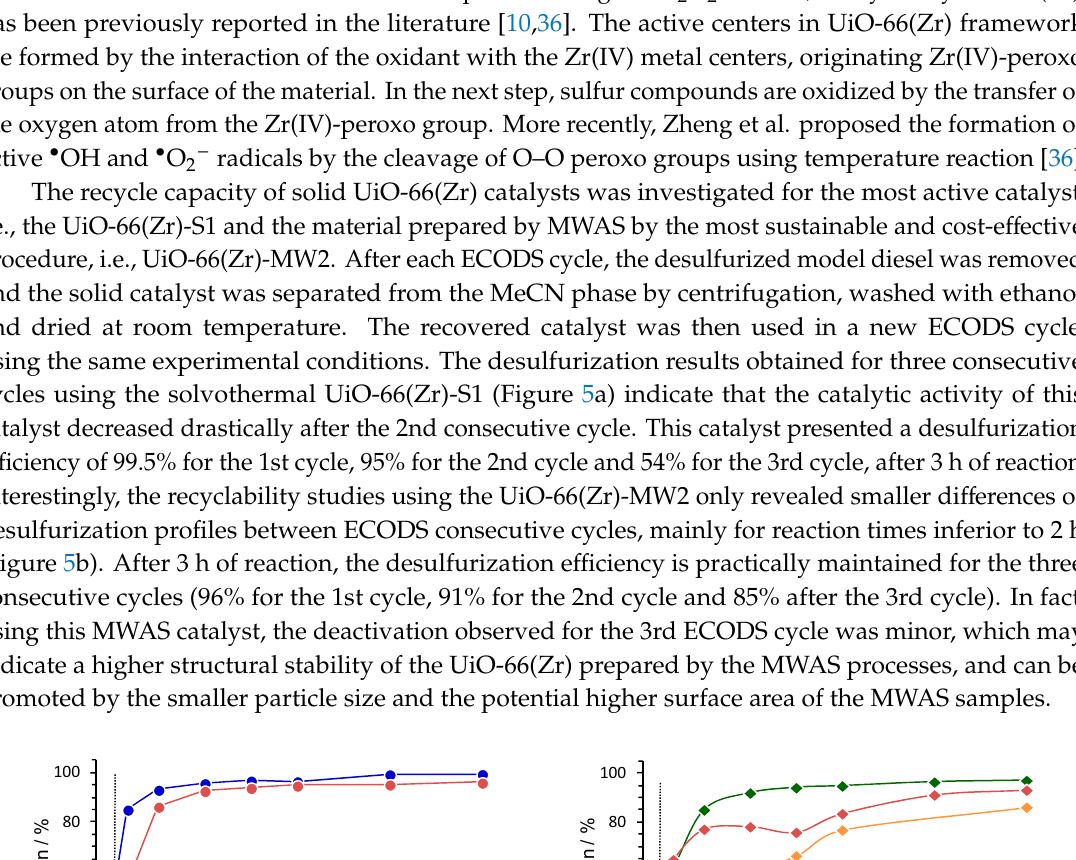
Figure 6. Desulfurization efficiency of UiO-66(Zr) catalysts used in different model diesel sulfur contents under similar experimental conditions (biphasic system model diesel/MeCN system, and H 2 O 2 as oxidant at 50–60 °C [9,37]. The catalytic desulfurization efficiency of the UiO-66(Zr) catalyst prepared in this work by the solvothermal procedure (UiO-66(Zr)-S1) and by the fast preparation procedure using MWAS (UiO- 66(Zr)-MW2) to treat the multicomponent model diesel with 1-BT and DBT derivatives is also compared in Figure 6. Only a slight difference of efficiency is observed after 0.5 h, having the MWAS catalyst 85% of efficiency instead of 93% obtained with the solvothermal material. This difference of